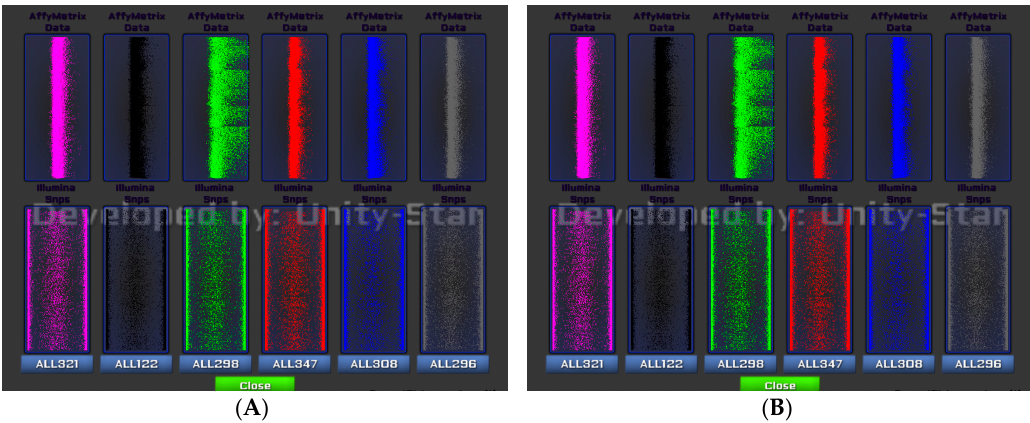
Figure 4. Gene comparison in Unity 3D environment where ( A ) displays the genetic property of six selected patients (top → microarray values and bottom → SNPs values) and ( B ) shows the visualisation of the other six patients when the genetic panels of patient ALL302 are overlaid with patient ALL53.